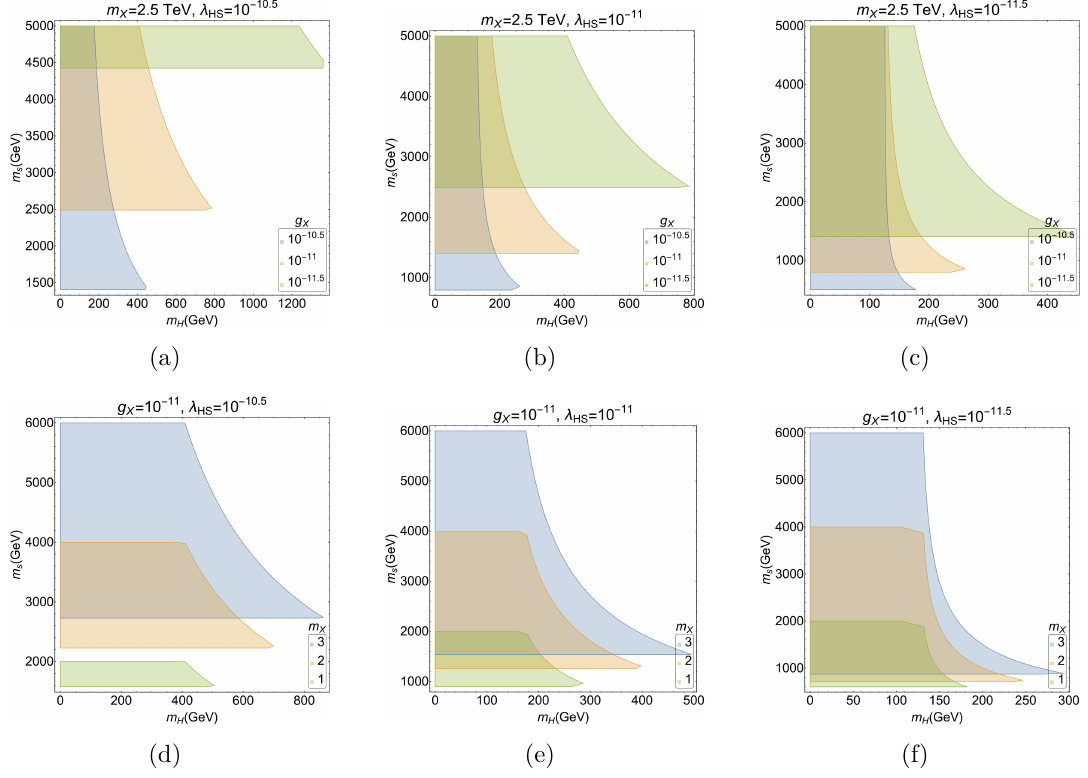
Figure 22 . Allowed parameter space in m H − m s plane constrained by the requirement of obtaining 125.1 GeV SM Higgs after EWSB. | sin[ θ ] | . 0 . 3 and 0 < λ H ≤ 4 π . FIMP mass ( m X ) is varied